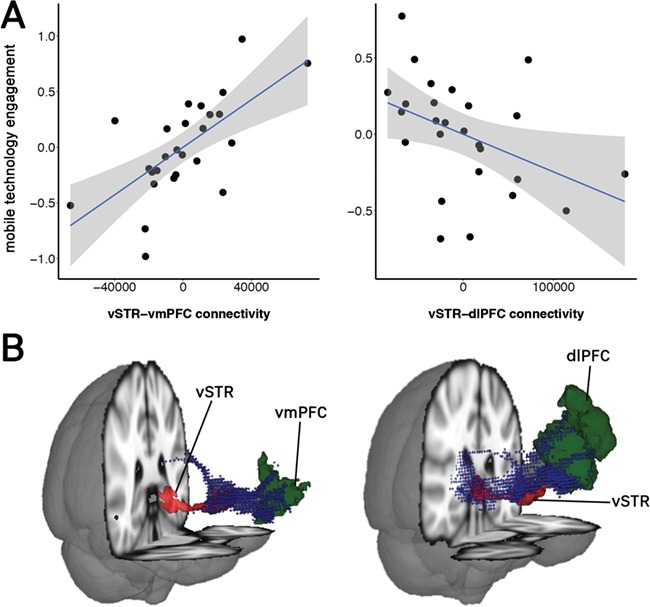

(A) Partial residual plots from vSTR linear regression model, illustrating relationship between MTE and white matter connectivity. (B) Visualization of white matter computed via probabilistic tractography between the vSTR and the vmPFC, and between the vSTR and dlPFC, for a representative participant.